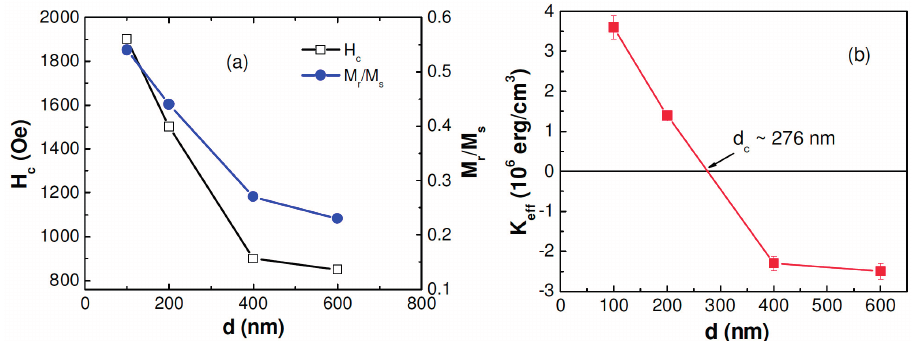
Figure 6. ( a ) Wire-diameter dependence of the coercive field ( H c ) and the remanence to saturation magnetization ratio ( M r / M s ) for the magnetic field applied parallel to the nanowire axis; ( b ) wire-diameter dependence of the effective anisotropy constant ( K eff ) of ordered CoNiP